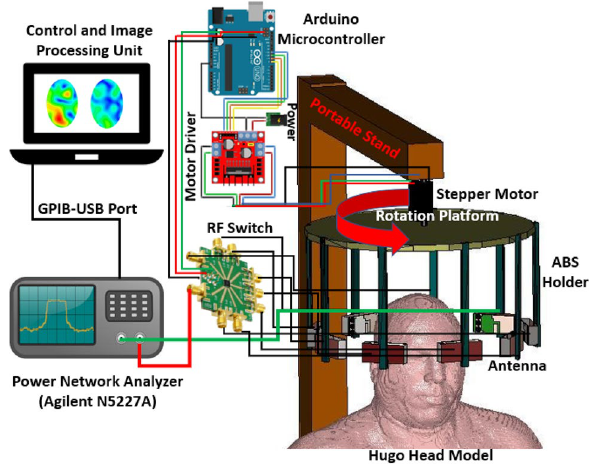
Figure 13. The schematic diagram of the portable EM head imaging